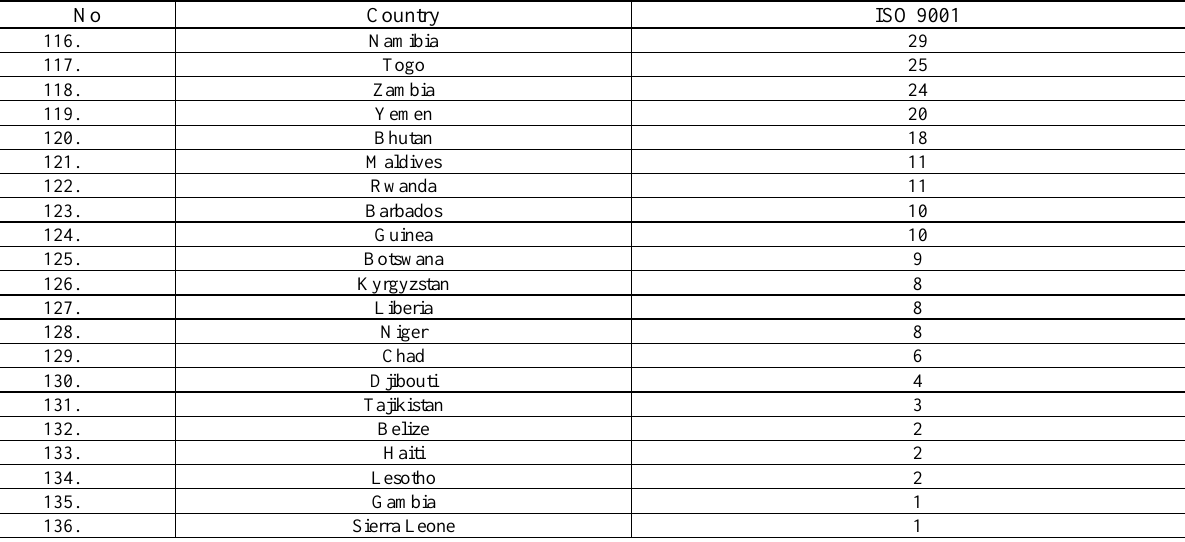
Table 2 (cont.). List of countries for ISO 9001 certificates issued based on the higher value of ISO 9001 certificates issued (136 countries worldwide, drawn from the author of this paper from the ISO table of the list of countries per alphabetic order, using Excel)